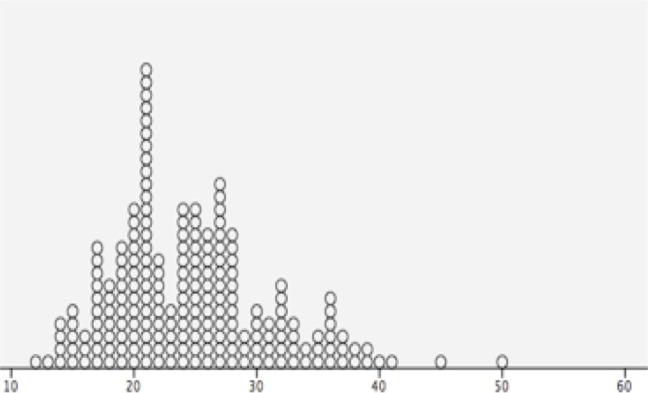
Scatterplot by SPSS software of the maximum tortuosity in degrees.This scatterplot shows how to divide the normal tortuosity in degrees. Most patients have a maximum tortuosity < 30°, so the cut-off point between low and moderate tortuosity is 30°.